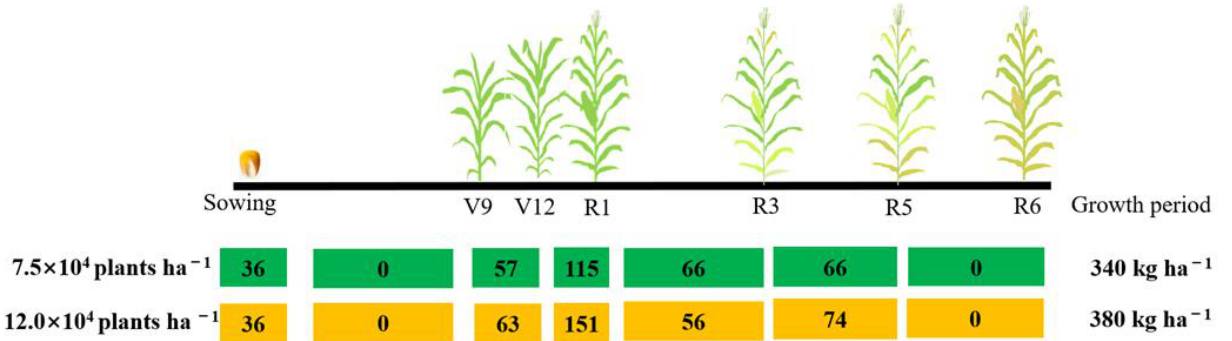
Figure 7. Fertilization amount during the maize growth period: the 9-leaf stage (V9), 12-leaf stage (V12), silking stage (R1), milk-ripening stage (R3), wax-ripening stage (R5), and mature stage (R6).